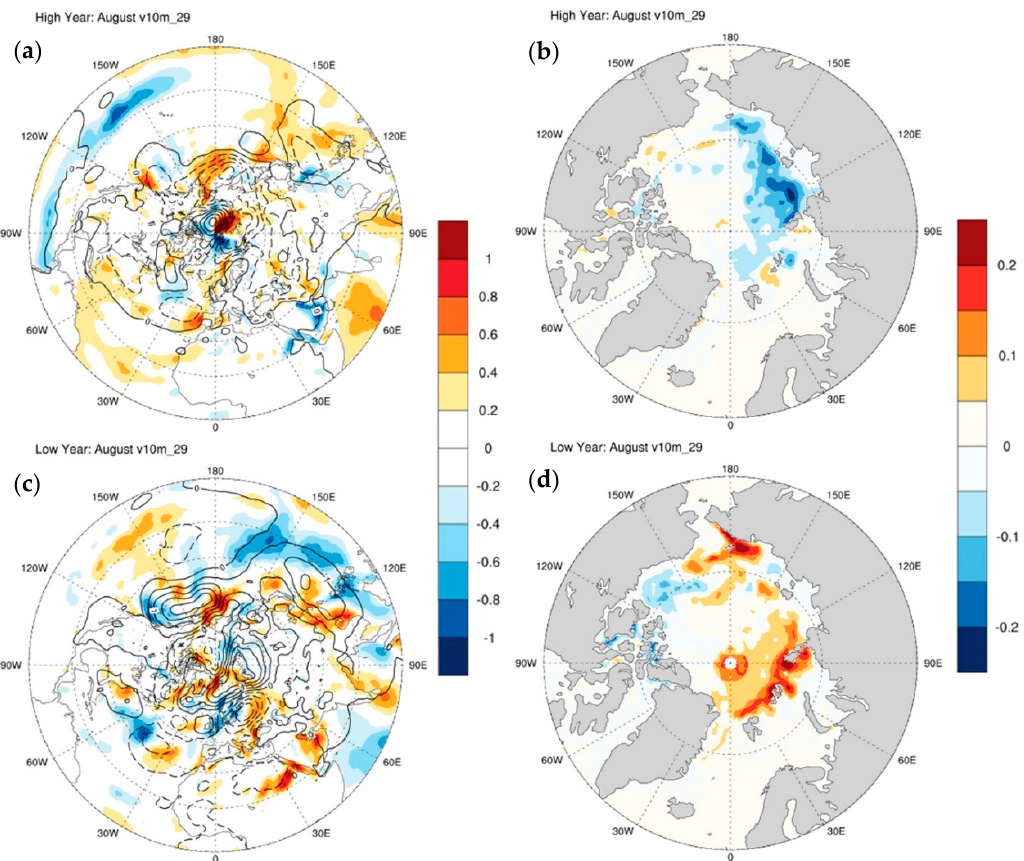
Figure 6. Composite anomalies of ( a , c ) August meridional component of wind at 10 m (shade interval: 0.2 m/s) and sea-level pressure (contour interval: 0.5 hPa); and ( b , d ) September SIC (shade interval: 0.05). The top (bottom) two plots correspond to the years when August v10m_29 (6.3 ◦ N, 53.7 ◦ E) is one standard deviation larger than its climatology mean in the positive (negative) phase.